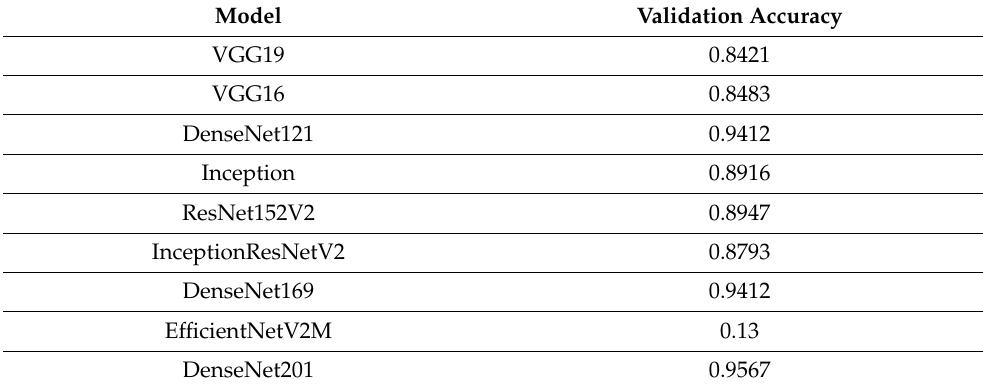
Table 7. Validation of transfer